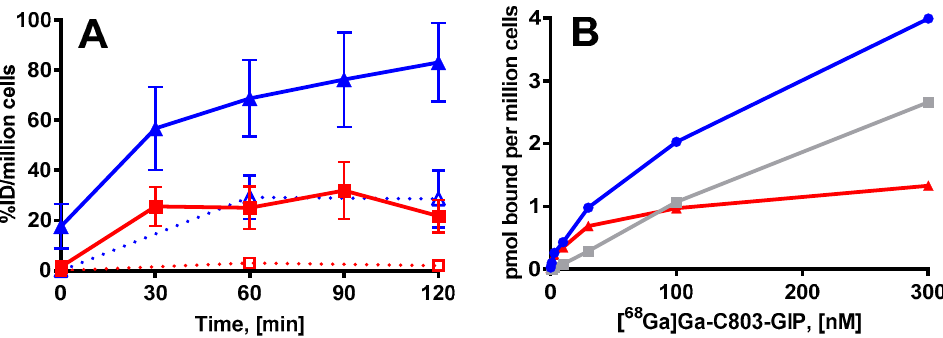
Figure 3. A : Total binding (blue) and internalization (red) of [ 68 Ga]Ga-C803-GIP in HEK293 cells expressing the GIPR presented as a function of time at 37 ◦ C (solid lines) and at 4 ◦ C (dotted lines) for the suppression of internalization. ( B ): GIPR binding saturation was achieved by gradually increasing the concentration of [ 68 Ga]Ga-C803-GIP. The total binding (blue), non-specific binding (grey), and specific binding (red, calculated by the subtraction of non-specific binding from the total binding). Data from a representative experiment are shown.